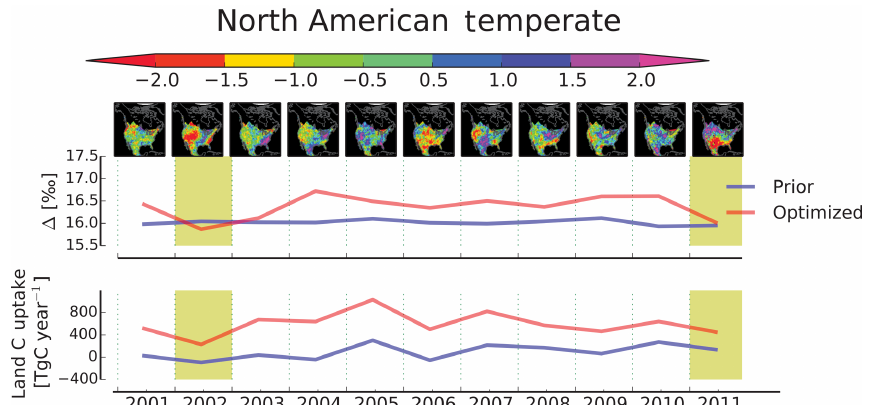
Figure 10. Top panels: the annual averaged Standardized Precipitation and Evaporation Index (SPEI) estimated for the North American tem- perate domain (map inserts). Middle panel: the annual GPP weighted averaged (cid:49) ph (‰) of vegetation against 13 CO 2 from NEW − CO2C13 (red) and SiBCASA (blue) estimated for the same domain. It illustrates the summertime isoforcing of δ 13 C towards the atmosphere (as wintertime (cid:49) ph has no impact on atmospheric δ 13 C). Lower panel: net carbon uptake (TgCyr − 1 ) from NEW − CO2C13 (red) and SiBCASA (blue) estimated for the same domain. The yellow shaded years (2002 and 2011) indicate significant drought conditions as recorded in SPEI and other independent reports (e.g., Seager, 2010; Schwalm et al., 2012; Long et al., 2013). These droughts correlate with reductions in annual mean (cid:49) ph , and reductions in the estimated carbon sinks as reported in Peters et al.